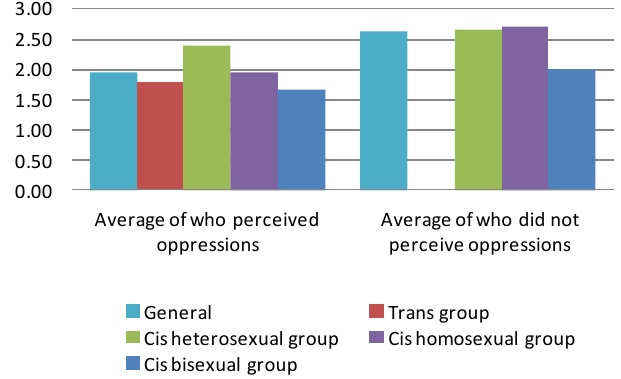
Fig. 7 – Percentage of response actions taken by each group Cis heterosexual population presented lesser preference for direct actions than the others, and more inclination to not taking actions. The exception was to write a post, chosen more times by the cis heterosexual group than by the homosexual. To report